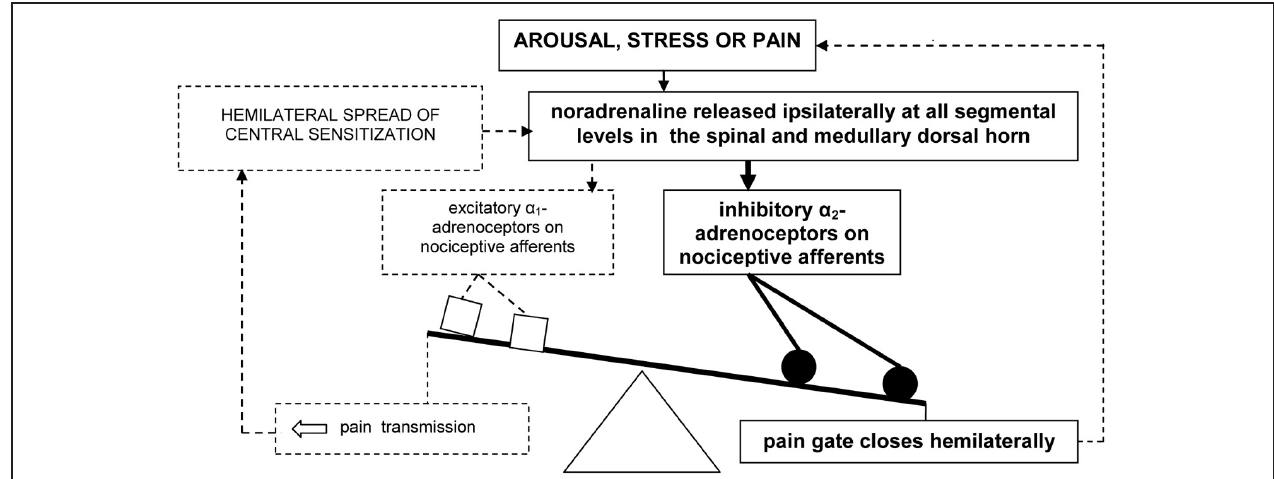
FIGURE 1 | Model of hemilateral inhibitory pain modulation (in bold). The dashed lines represent failure to engage hemilateral facilitatory pain transmission and associated emotional